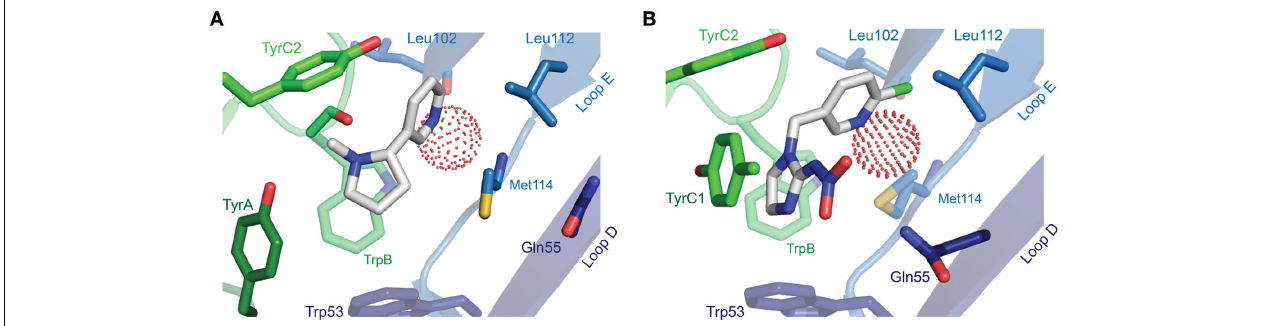
FIGURE 6 | X-ray crystallographic structures of other notable agonists. (A) L. stagnalis AChBP in complex with nicotine (PDB entry 1UW6). (B) L. stagnalis AChBP in complex with imidacloprid (PDB entry 2ZJU). A red sphere illustrates the oxygen atom of a water molecule